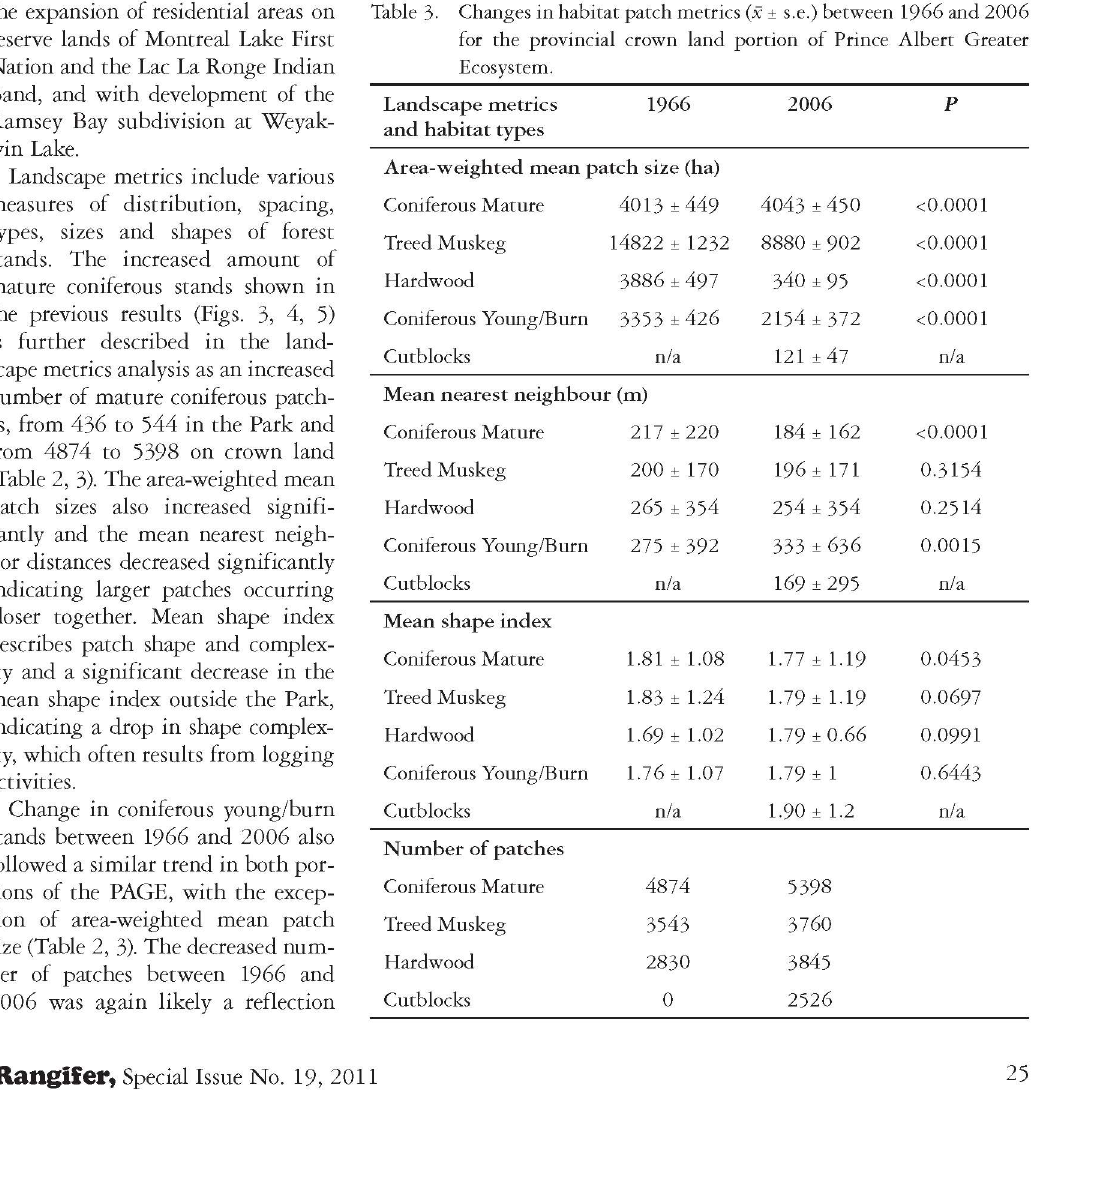
for the provincial crown land portion of Prince Albert Greater